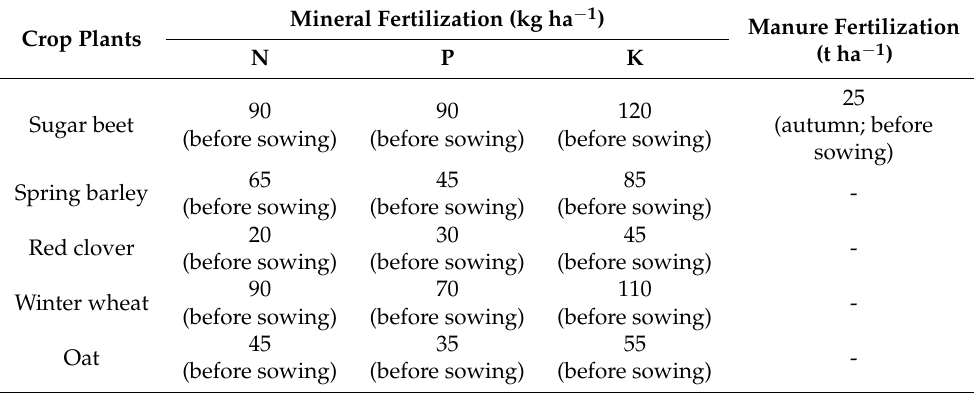
Table 4. Fertilization of spring wheat forecrops used in the conventional